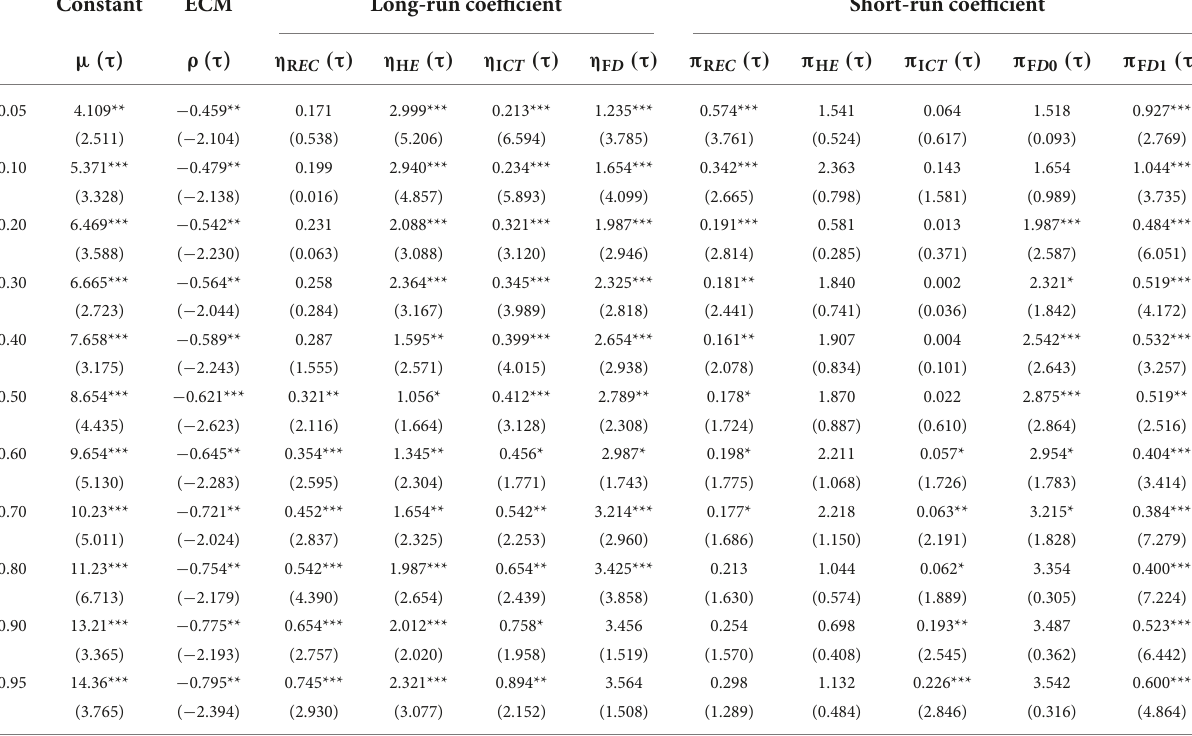
TABLE 5 QARDL estimates of green